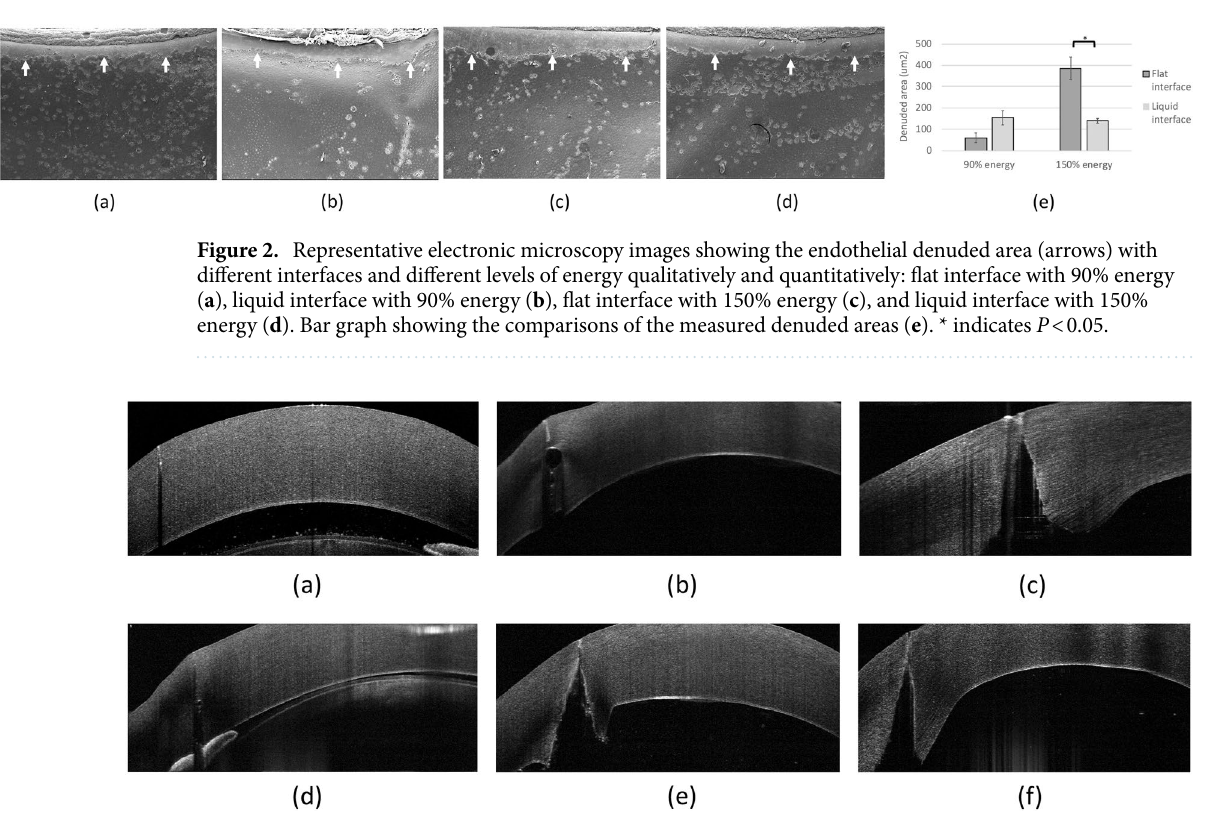
Figure 3. Representative ASOCT images showing the trephine incisions after FSL trephination with different interfaces and different levels of energy. Flat interface with 30% energy ( a ), flat interface with 90% energy ( b ), flat interface with 150% energy ( c ), liquid interface with 30% energy ( d ), liquid interface with 90% energy ( e ), and liquid interface with 150% energy ( f